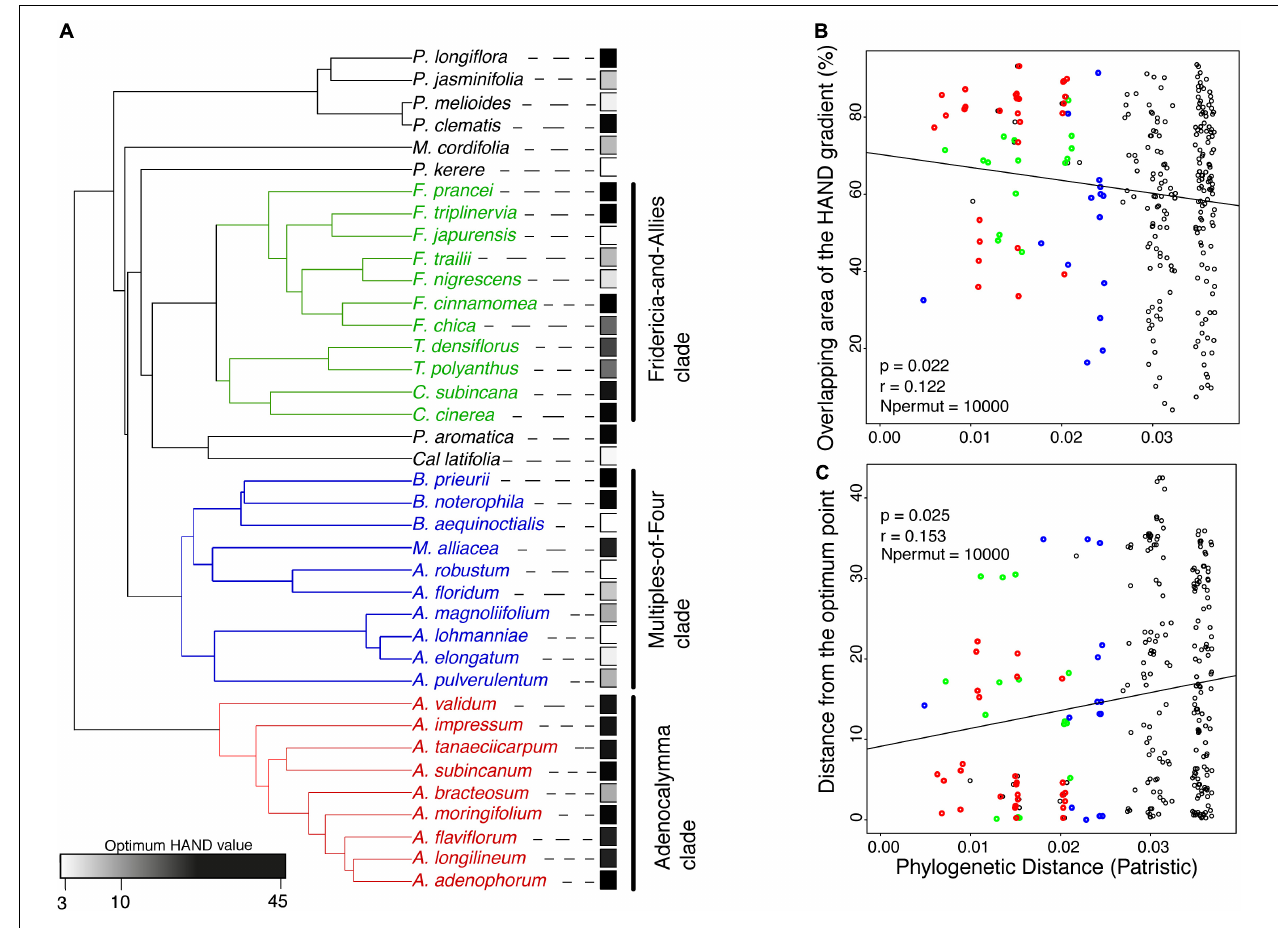
FIGURE 5 | Relationship between phylogenetic pattern and liana species distribution of the tribe Bignonieae in the HAND gradient. (A) Phylogenetic relationship of the tribe Bignonieae with the optimum value of each species in the HAND gradient. (B) Negative relationship between the overlapping area of the HAND gradient and the Phylogenetic Distance (Patristic). (C) Positive relationship between the distance from the optimum value of each species in the HAND gradient and the phylogenetic distance (Patristic). See Figure 1 for abbreviations of scientific terms. Red, blue, and green highlight the three main clades of the tribe Bignonieae: Adenocalymma , Multiples-of-Four, and Fridericia-and-Allies, respectively. Black points represent other species of the tribe